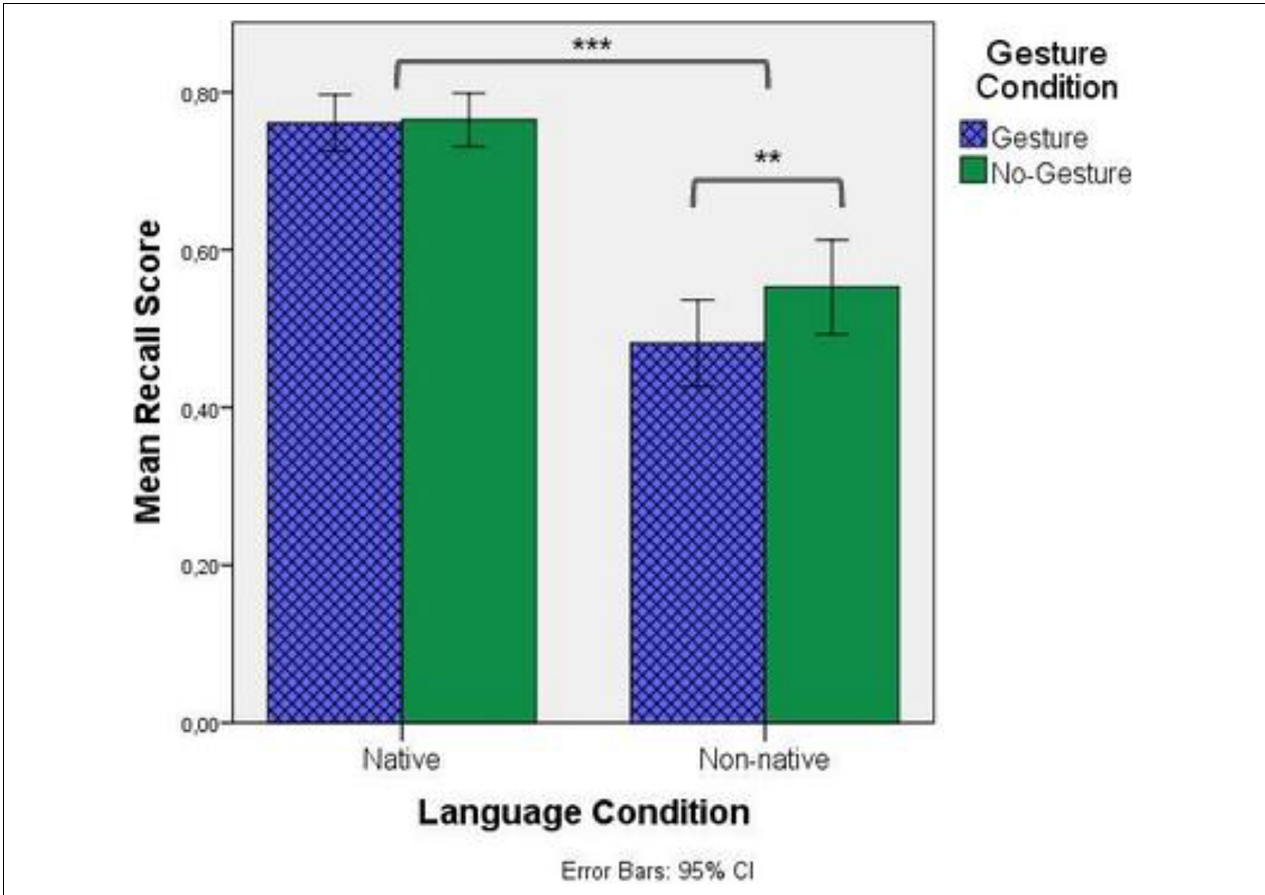
FIGURE 3 | Mean recall scores by Language and Gesture conditions. “**” Refers to a p -value less than 0.01, while “***” refers to a p -value less than